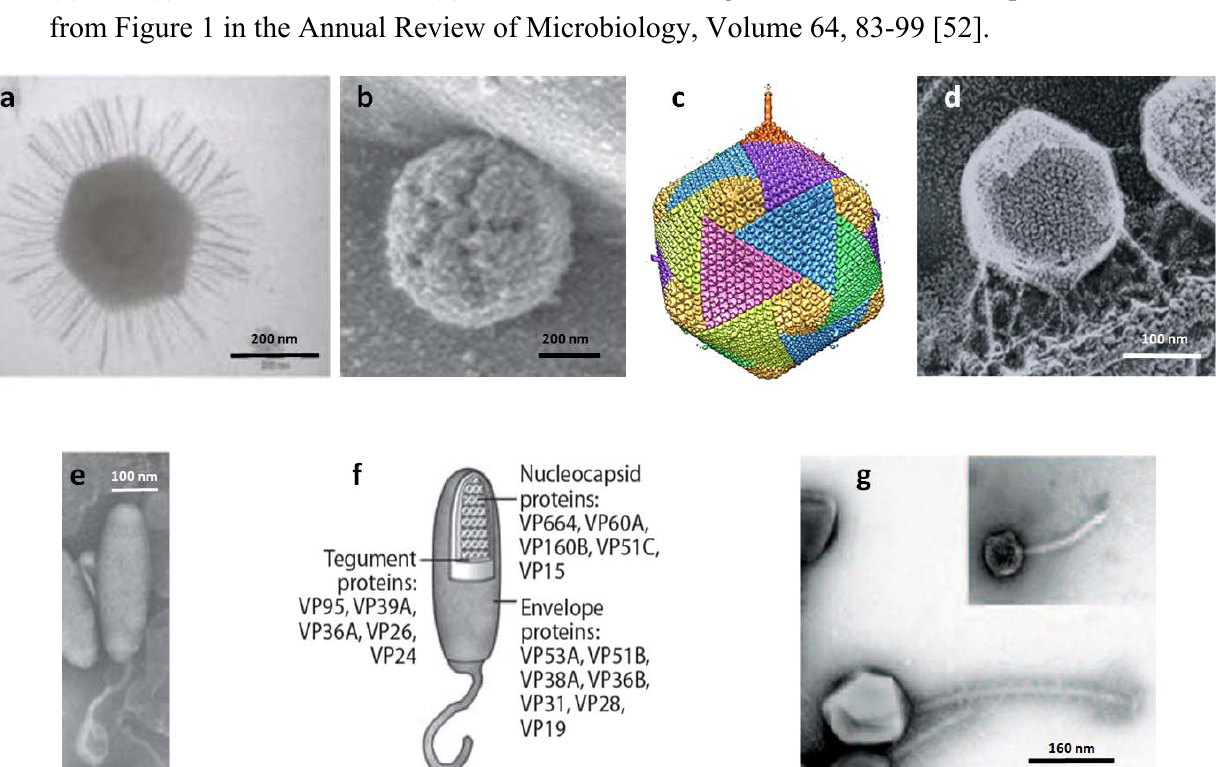
Figure 1: ( a ) Transmission electron micrograph of Mimivirus. ( b ) Atomic force microscopy of defibered Mimivirus. The unique star-faced vertex is clearly visible. ( c ) Five-fold averaged cryo-electron micrographs of virus PBCV-1 reveal a long, thin, cylindrical spike structure at one vertex and protrusions (fibers) extending from one unique capsomer per trisymmetron. ( d ) PBCV-1 attached to the cell wall as viewed by the quick- freeze, deep-etch procedure. Note fibers attach the virus to the wall. ( e, f ) Morphology of the White spot shrimp virus (WSSV) virion. ( e ) Negative contrast electron micrograph of intact WSSV virion with its tail-like extension. ( f ) Schematic based on panel e showing the layered structures of a WSSV virion, i.e. , envelope, tegument, and nucleocapsid. ( g ) Electron micrograph of bacteriophage G. The insert shows coliphage lambda to the same scale. Panel ( a ) is from [77], ( b ) is from [58], ( c ) is from [78], ( d ) is from [79], ( e ) and ( f ) are from [80], and ( g ) is from [50]. The figure is modified, with